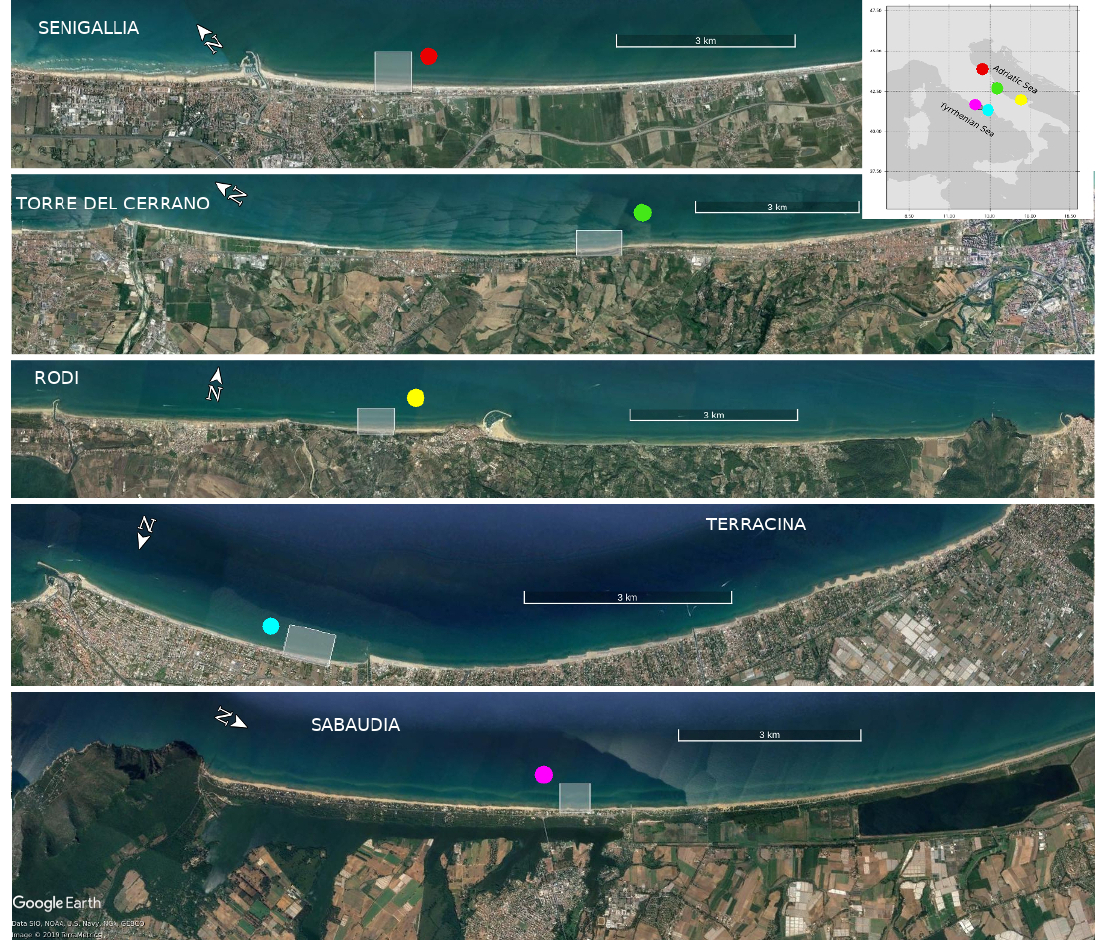
Figure 1. The five investigated locations (pictures taken from Google Earth). From top to bottom: Senigallia, Torre del Cerrano, Rodi Garganico, Terracina and Sabaudia. The shaded areas indicate the video-monitored portions of